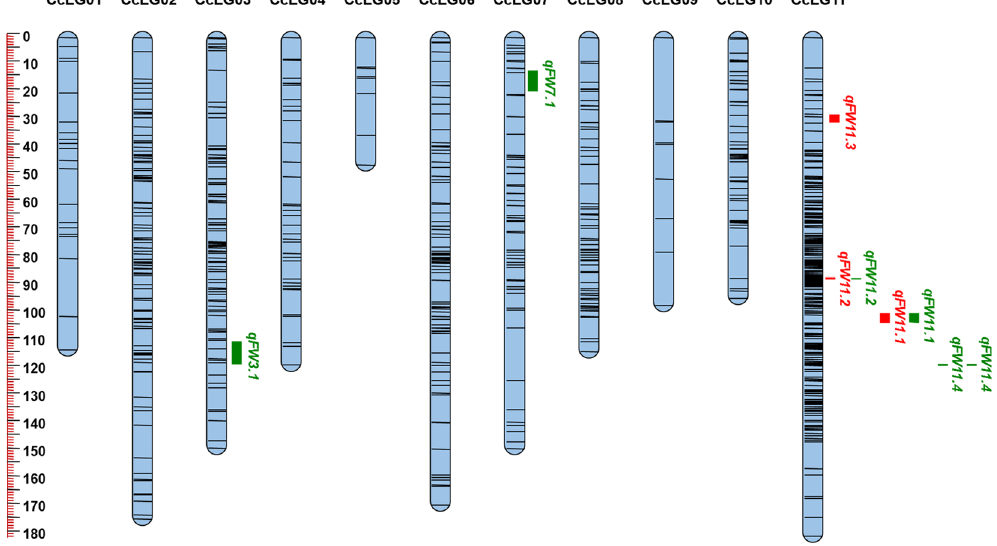
Figure 2. SNPs- based genetic map and distribution of QTLs associated with FW resistance in PRIL_B (ICPL 20096 × ICPL 332). The scale is on the left indicating genetic distance (centi Morgan; cM as unit). The black lines in the linkage groups represent the genetic position of the markers. A total of three linkage groups, namely CcLG03, CcLG07, and CcLG11 possess six QTLs for FW resistance. QTLs for FW resistance identified at Patancheru and Gulbarga locations were represented as a vertical bar in green and red colors, respectively.